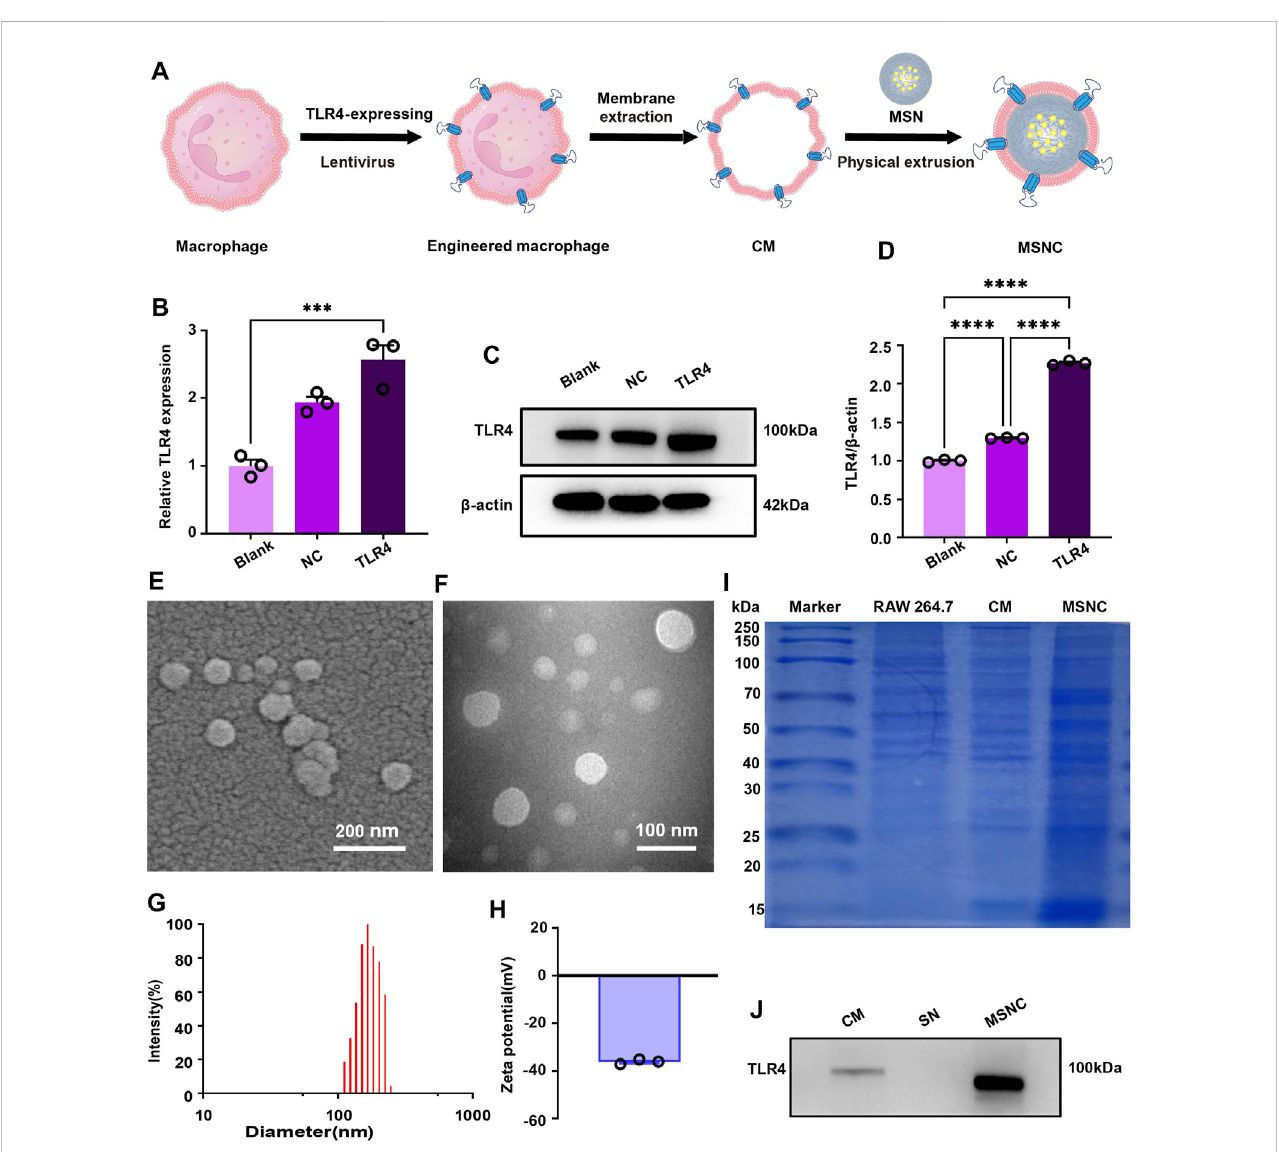
FIGURE 3 Characterization of functioned cell membrane coated silk fi broin nanoparticles loaded with minocycline hydrochloride. (A) Schematic illustration of MSNCs. (B) TLR4-expressing in RAW264.7 cells by RT-PCR. (C) TLR4-expressing in RAW264.7 cells by WB. (D) Quantitative analysis of the WB. (E) Scanning electronmicroscopyofMSNCs. (F) TEMofMSNCs. (G) ParticlesizedistributionofMSNCs. (H) ZetapotentialdiagramofMSNCs. (I) Theproteincompositionof MSNCs was veri fi ed by SDS-PAGE followed by the Bradford staining. (J) The successful translocation of CMs proteins was veri fi ed by WB. Data